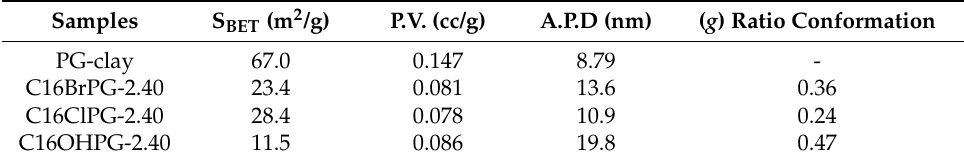
Table 5. Textural properties of PG clay and its organo-derivatives prepared from surfactant solution with different counter anions. The g conformation ratio was also